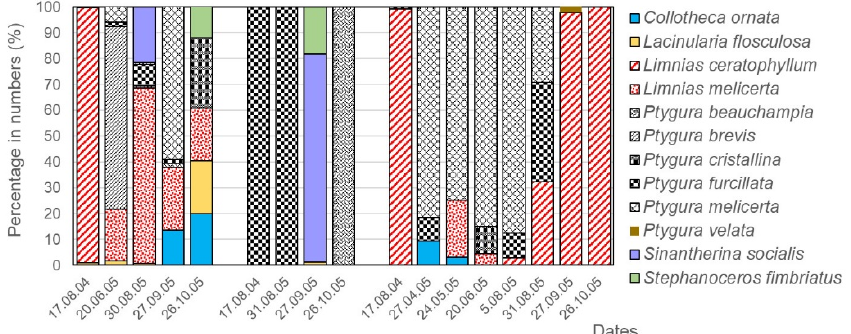
Figure 7. Percentage share of different species in the community of sessile Rotifera epiphytic on Vallisneria in the three Konin lakes.